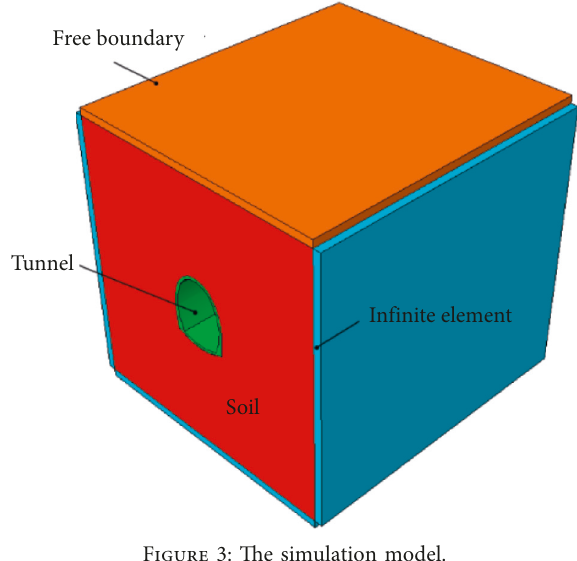
Figure 3: The simulation model.